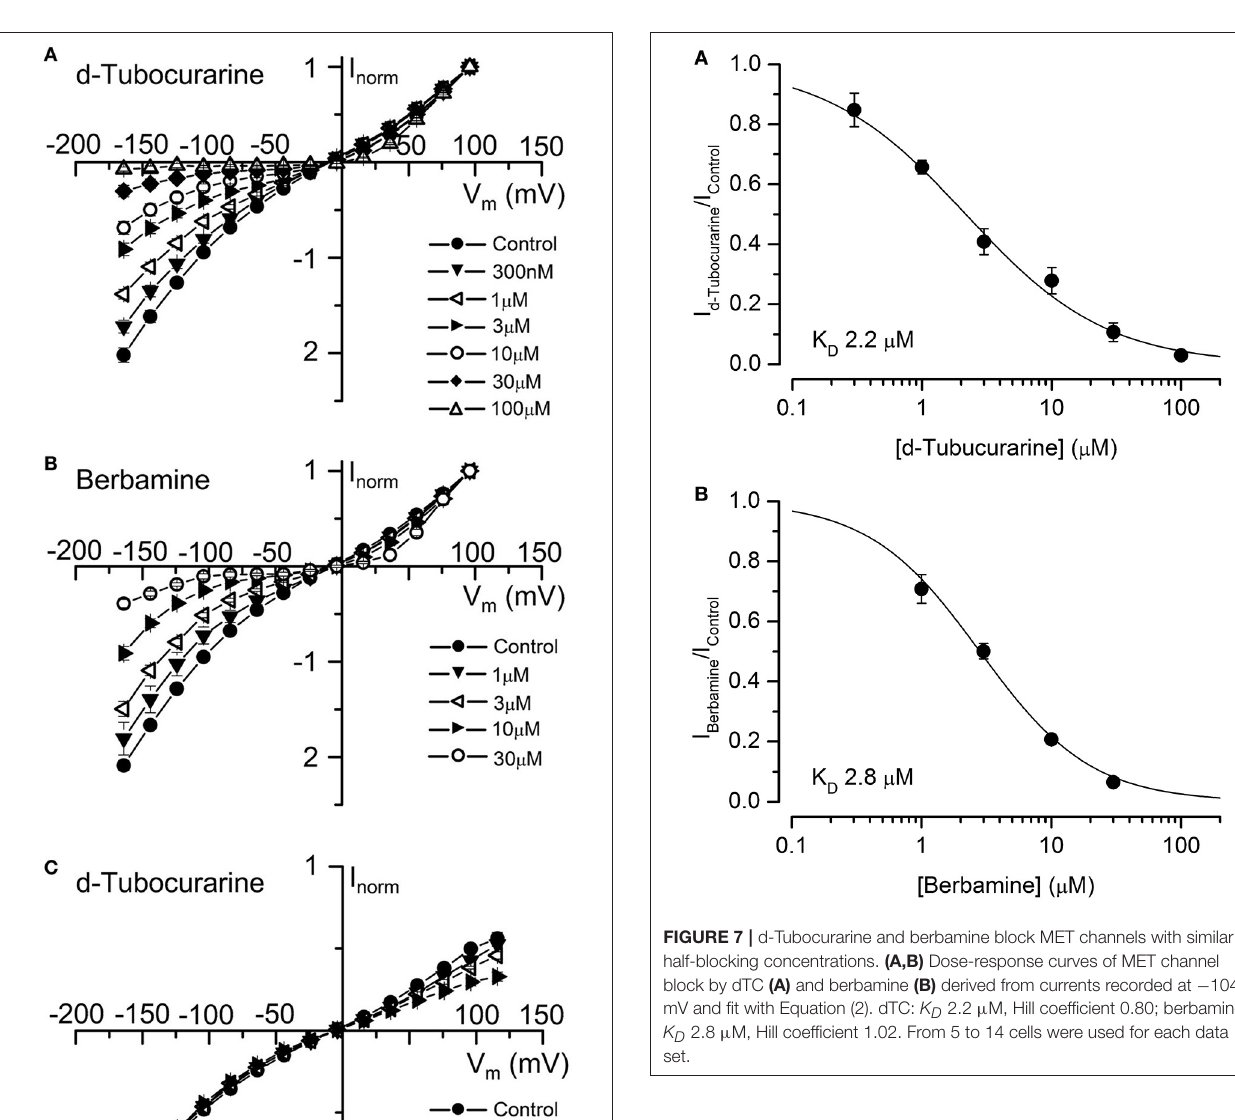
δ b is the relative electrical distance of the binding site along the